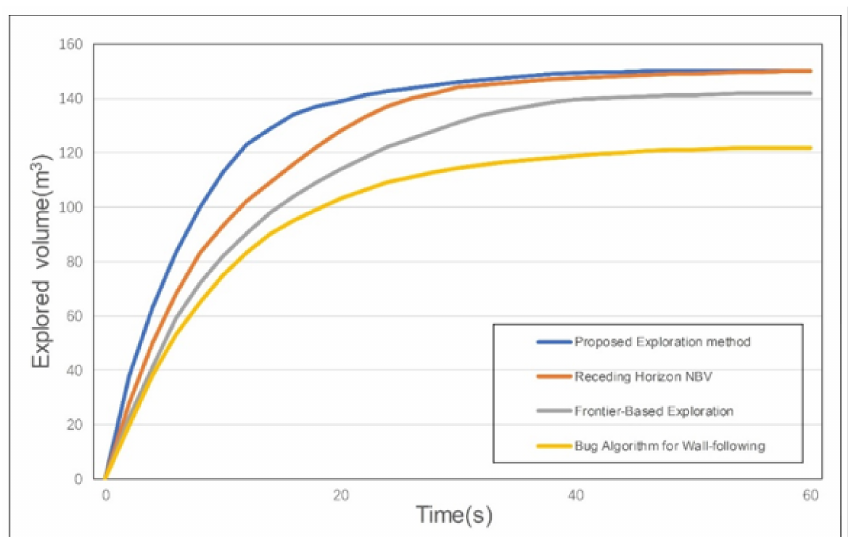
Figure 16. Maze environment explored volume over time by four algorithms.